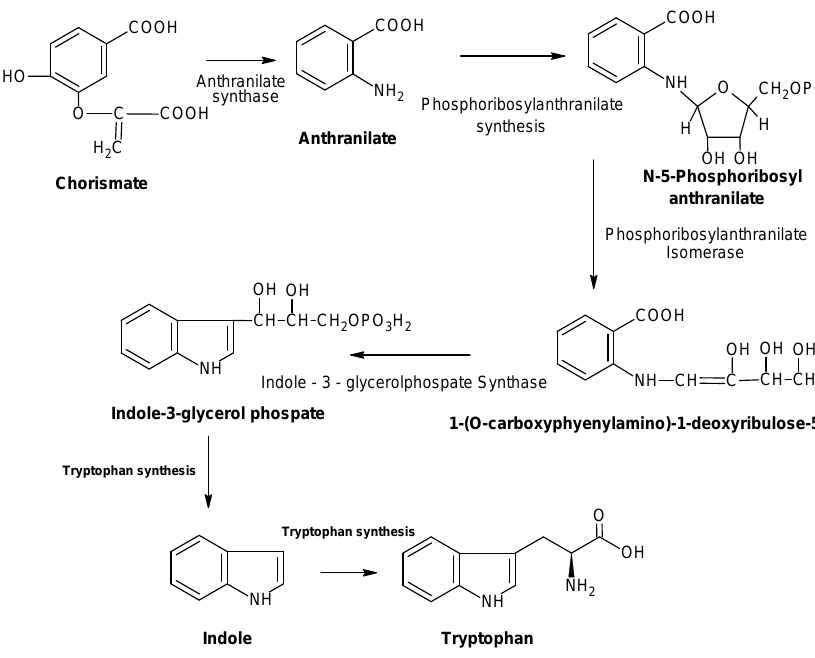
Figure 1. The metabolic pathway for the TRP biosynthesis (adapted from [3]). Figure 1. The pathway for the synthesis of TRP (adapted from [3]). Figure 1. The pathway for the synthesis of TRP (adapted from [3]).